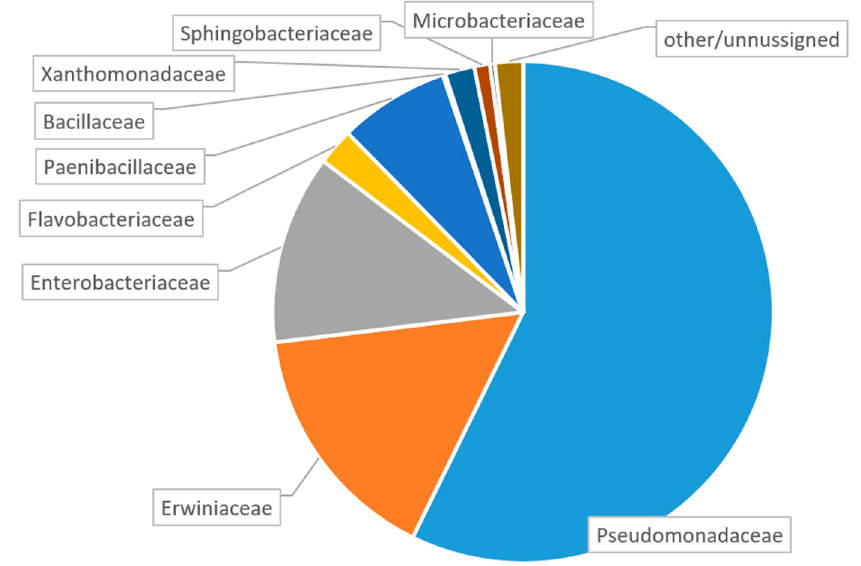
Figure 1. Relative abundance of the dominating families (>0.3%) of the Agrilus nal planipennis intestinal microbiome.